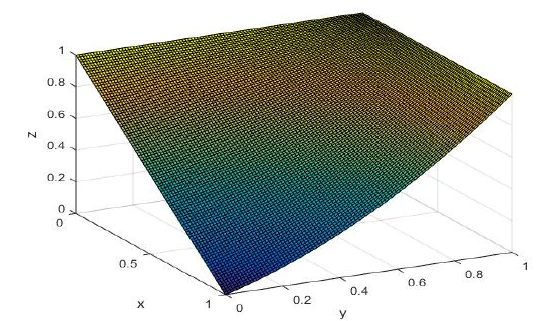
Figure 4. I implication of example 5.